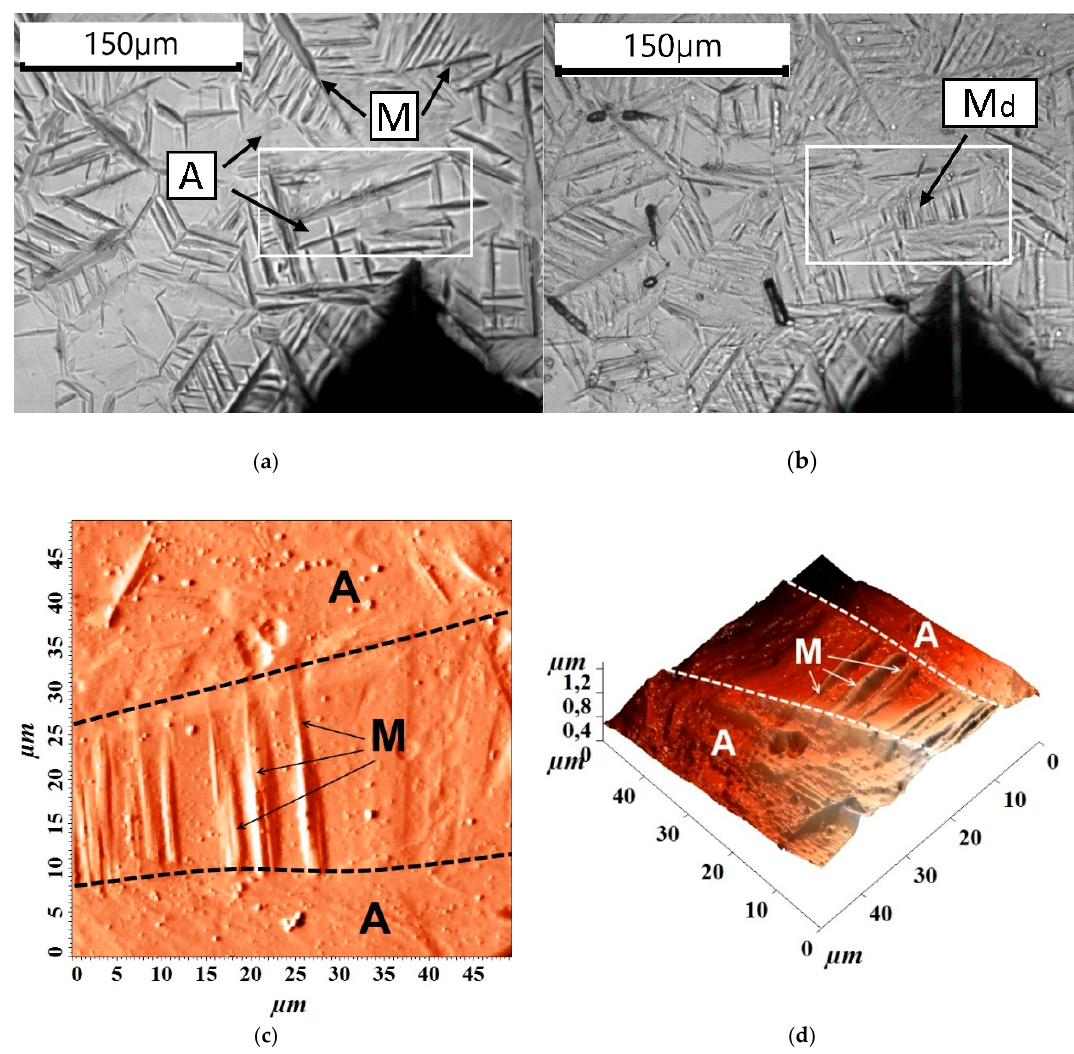
Figure 6. Microstructure of TRIP steel in state 2 ; ( a ) optical image of the undeformed specimen; ( b ) optical image after deformation in the pseudo-plateau region; ( c , d ) atomic force microscopy (AFM) image of the selected area. The top of the Vickers pyramid indentation served as a reference. A—austenite, Md—strain-induced martensite.